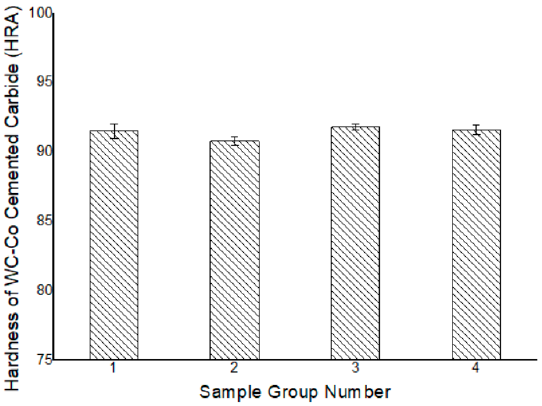
Figure 3. Hardness of WC–Co cemented carbide.